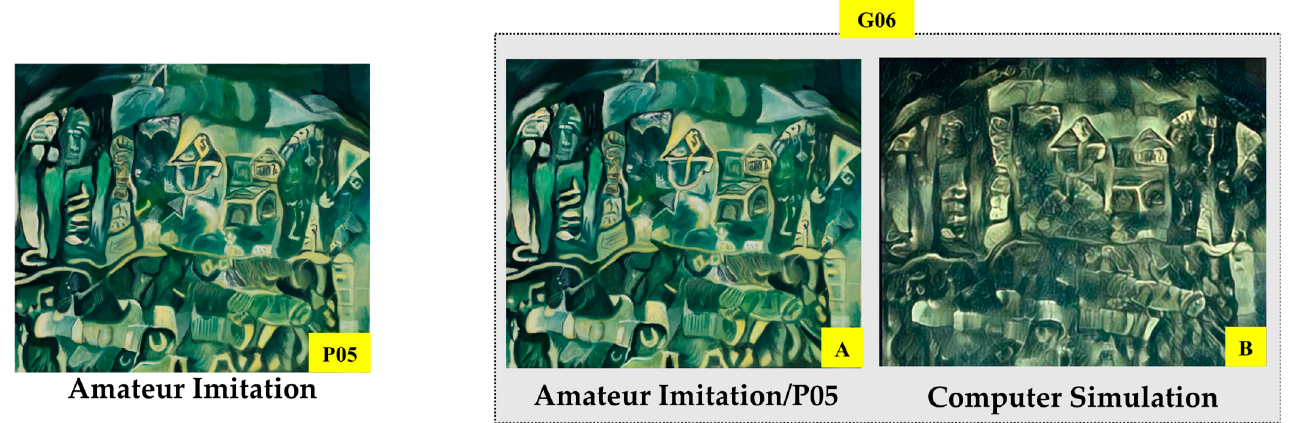
Figure 4. P05 and G06 are from the same original painting.